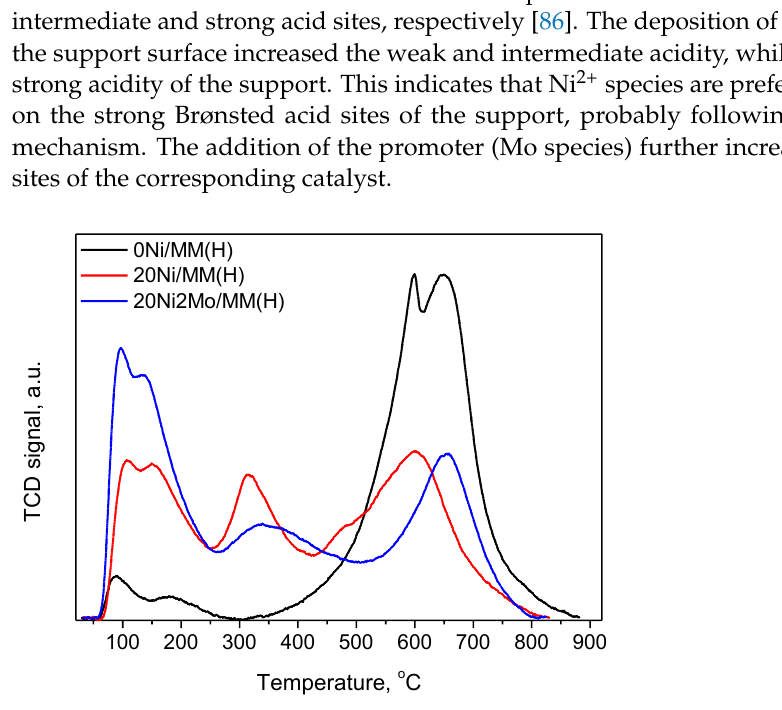
Figure 11. Deconvoluted XPS Ni2p and Mo3d peaks of the 20Ni/MM(H) and 20Ni2Mo/MM(H) cat- alysts.